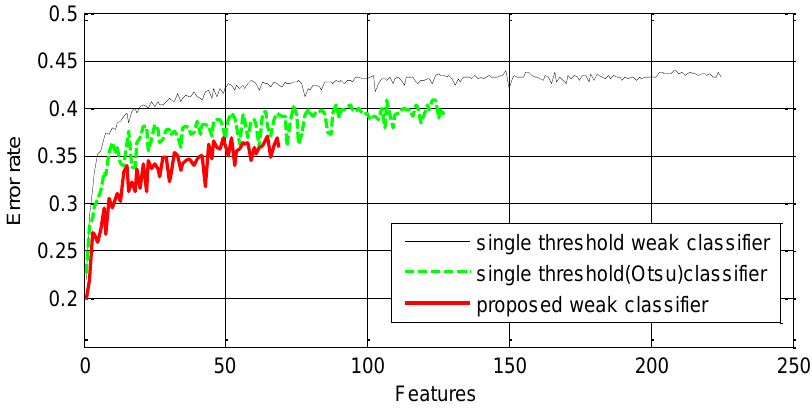
Figure 7. Distributions of feature values of the 6th ( left ) and the 9th ( right ) features selected by AdaBoost using the proposed weak classifiers. The features have error rate of 0.27 and 0.3 respectively under the proposed hypothesis. The single threshold